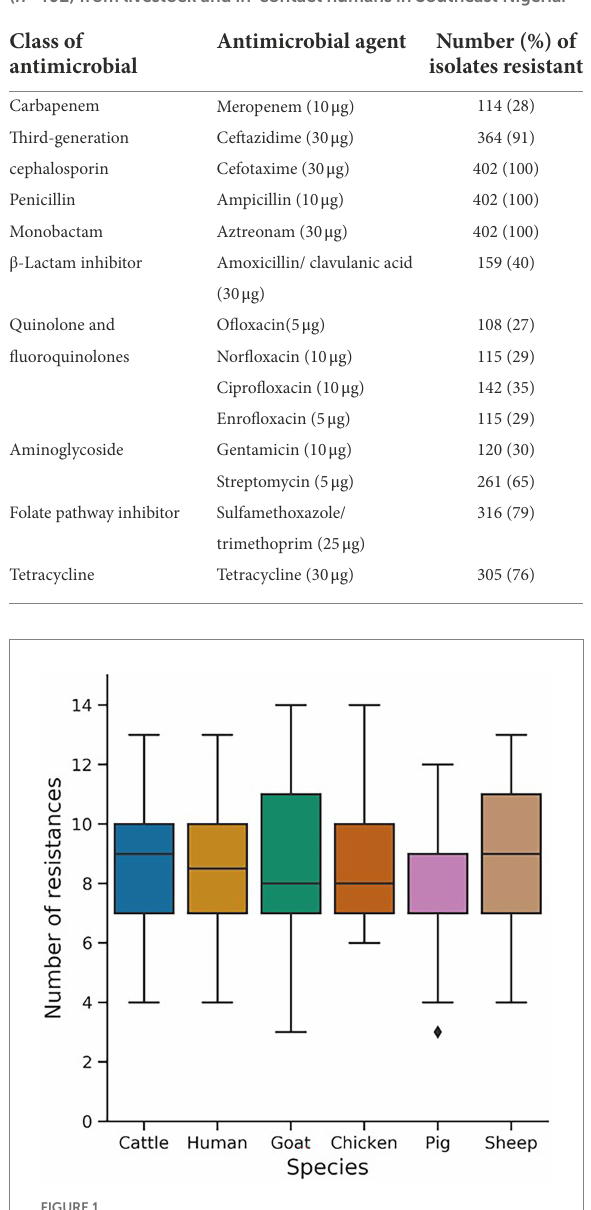
FIGURE 1 Box plot of the total number of resistances in Escherichia coli isolates ( n = 402) from different livestock species and in-contact humans. The 14 antimicrobials used for the antimicrobial susceptibility test include Meropenem (10 μ g), Ceftazidime (30 μ g), Cefotaxime (30 μ g), Aztreonam (30 μ g), Ampicillin(10 μ g), Amoxicillin/clavulanic acid (30 μ g), Enrofloxacin (5 μ g), Ofloxacin (5 μ g), Norfloxacin (10 μ g), Ciprofloxacin (10 μ g), Gentamicin (10 μ g), Streptomycin (5 μ g), Sulphamethoxazole/Trimethoprim (25 μ g), and Tetracycline (30 μ